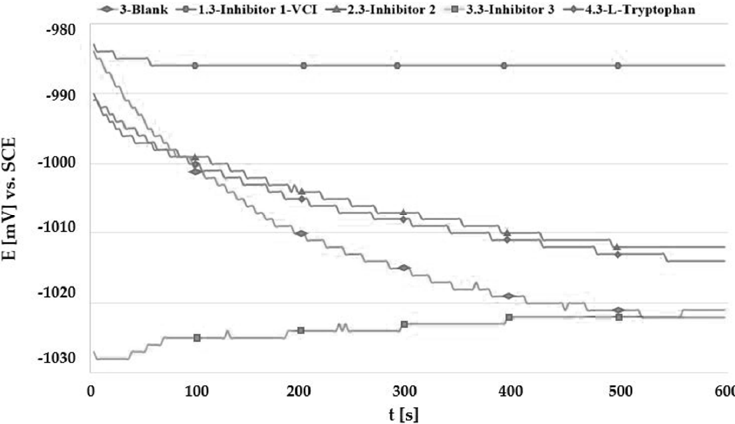
Figure 3. Corrosion potential diagram with and without the addition of inhibitors in 1% NaCl.